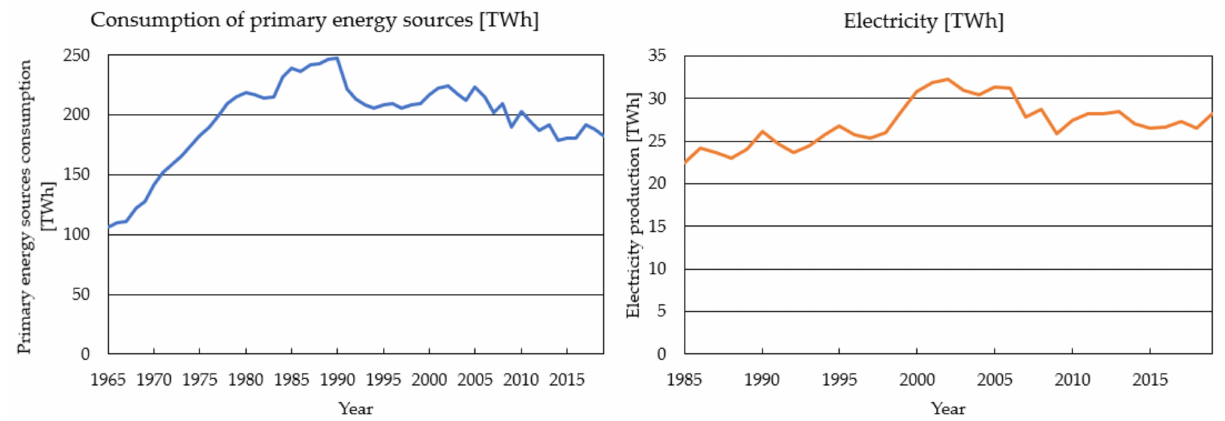
Figure 5. Primary energy consumption and electricity production of the Slovak republic